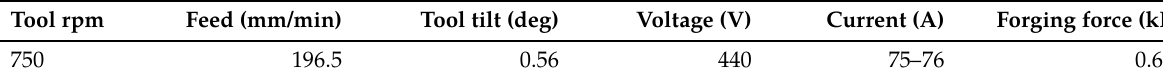
Table 2: Details of friction stir welding parameters. Tool rpm Feed (mm/min) Tool tilt (deg) Voltage (V) Current (A)